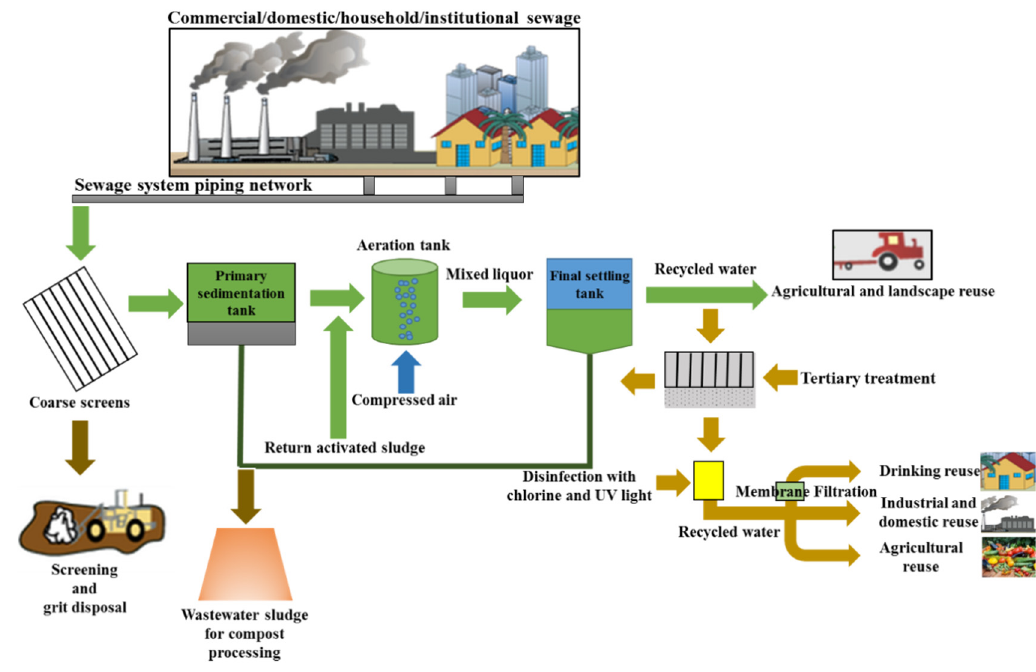
Figure 2. Water-reclamation process at the treatment facility modified from